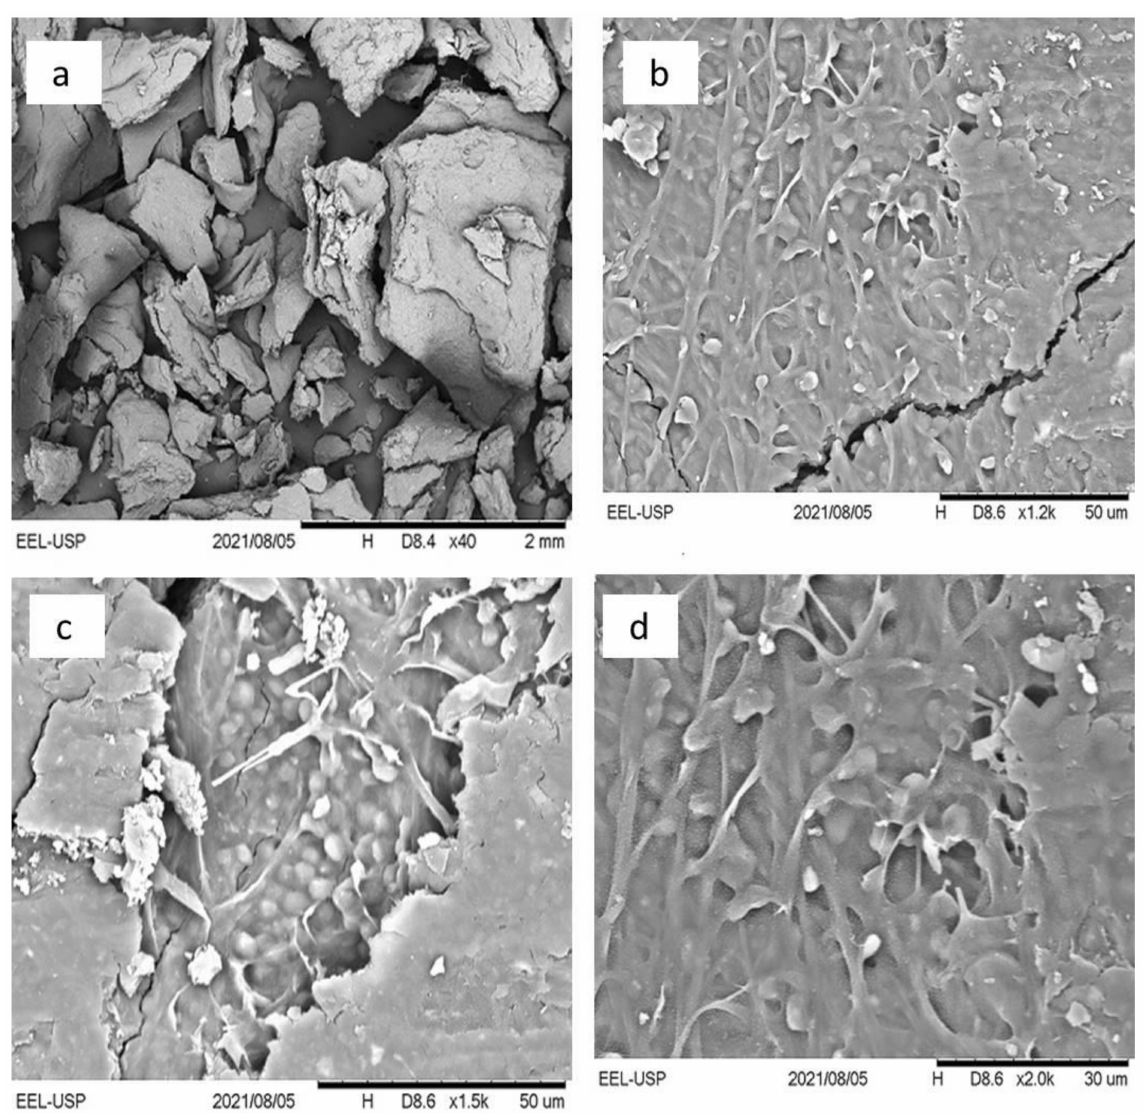
Figure 4. Scanning electron microscope pictures of the lichen-like structure composed of M. circinel- loides mycelium and S. obliquus cells at different magnifications: ( a ) 40 × , ( b ) 1200 × , ( c ) 1500 × , ( d ) 2000 × . In ( a ), the image of a biomass grain of the lichen-like structure can be observed. In ( b – d ), the fixation of algae cells (small drop shapes with white color) and fungal hyphae (in branch format with light gray color) can be well visualized. In ( c ) specifically, there are clumps of algae cells in certain places where the branch fungal mycelium also predominates and forms a nest structure. In ( c , d ), it can be observed that some algae are interconnected among filamentous